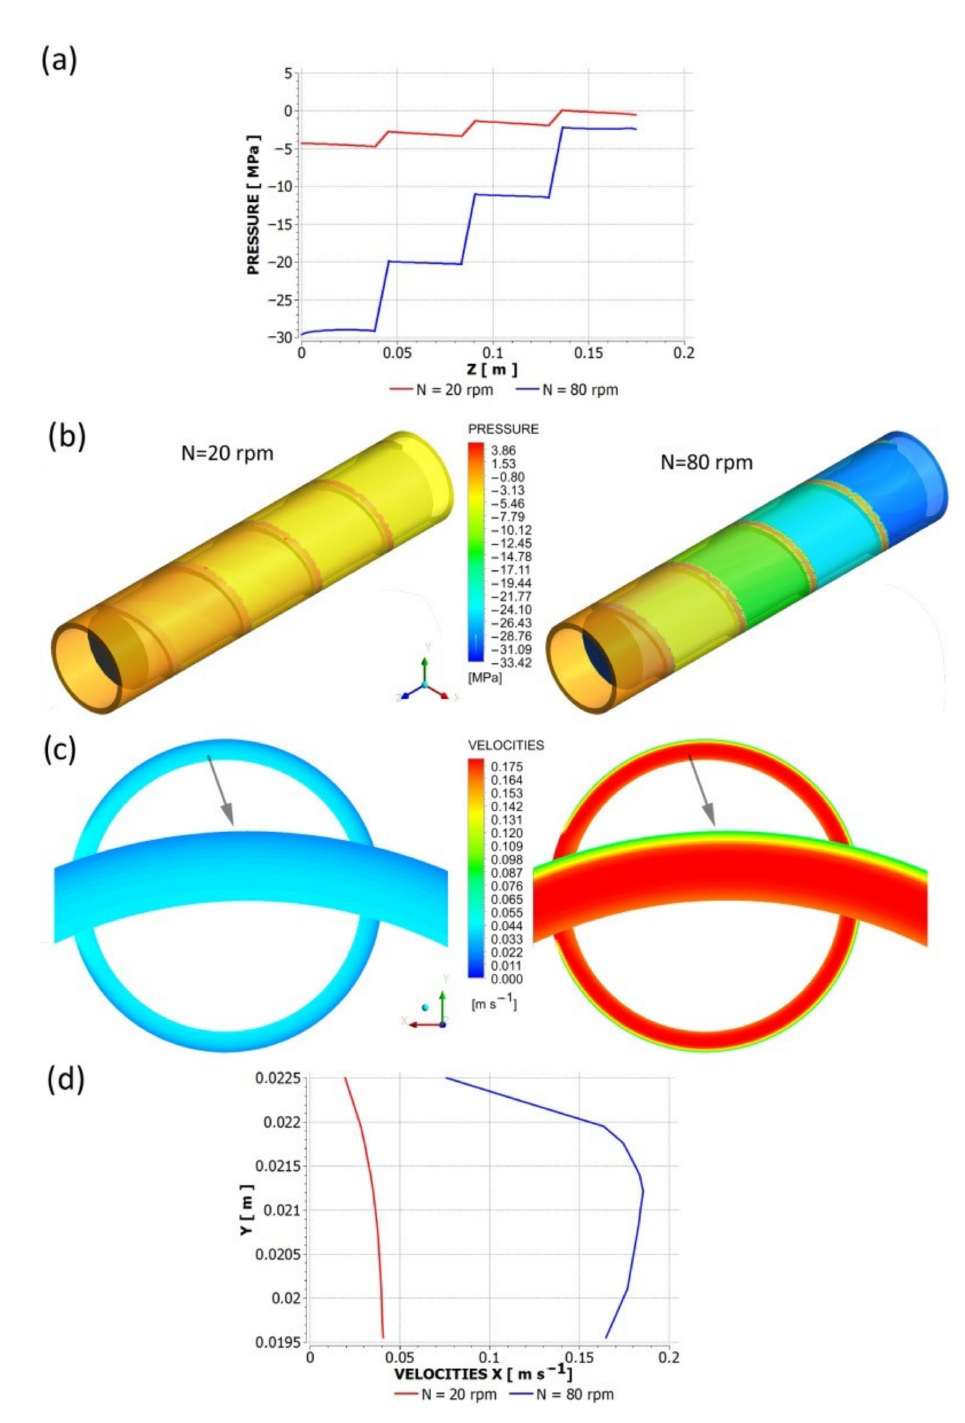
Figure 9. Pressure and velocity distributions for screw flow ( F slip = 0.064, e slip = 0.43): Q = 0.001 kg/s. ( a ) pressure profile, ( b ) pressure distribution, ( c ) velocity distribution, ( d ) velocity